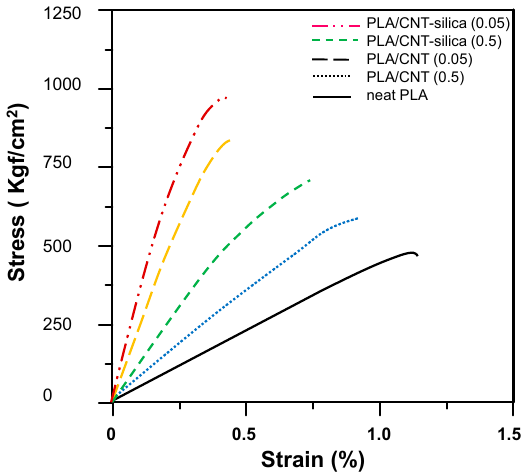
Figure 7. Stress–strain curves of neat poly(lactic acid) (PLA) and PLA-based nanocomposites.